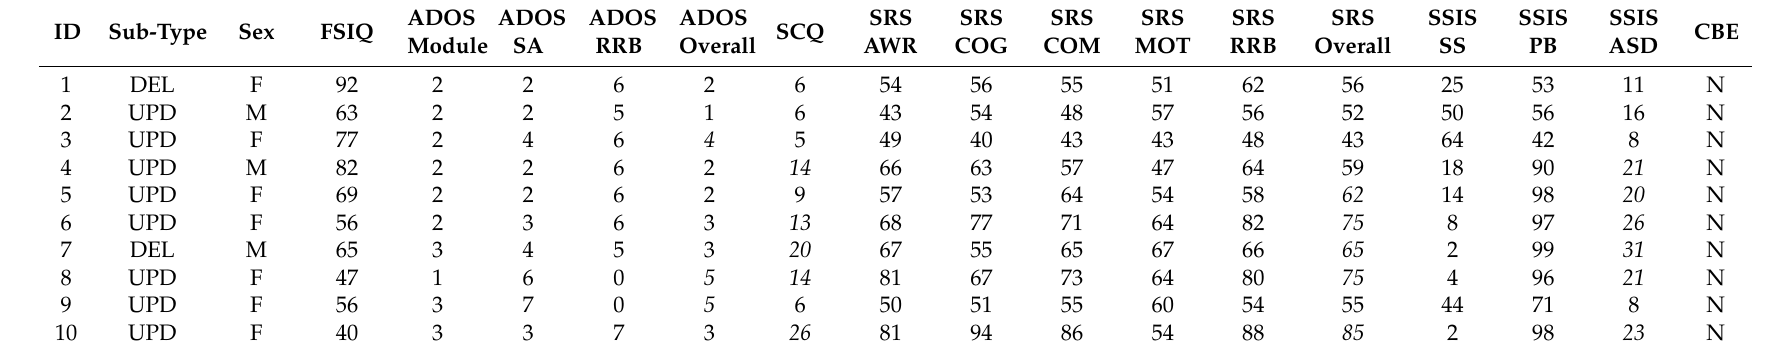
Table 2. Individual participant score